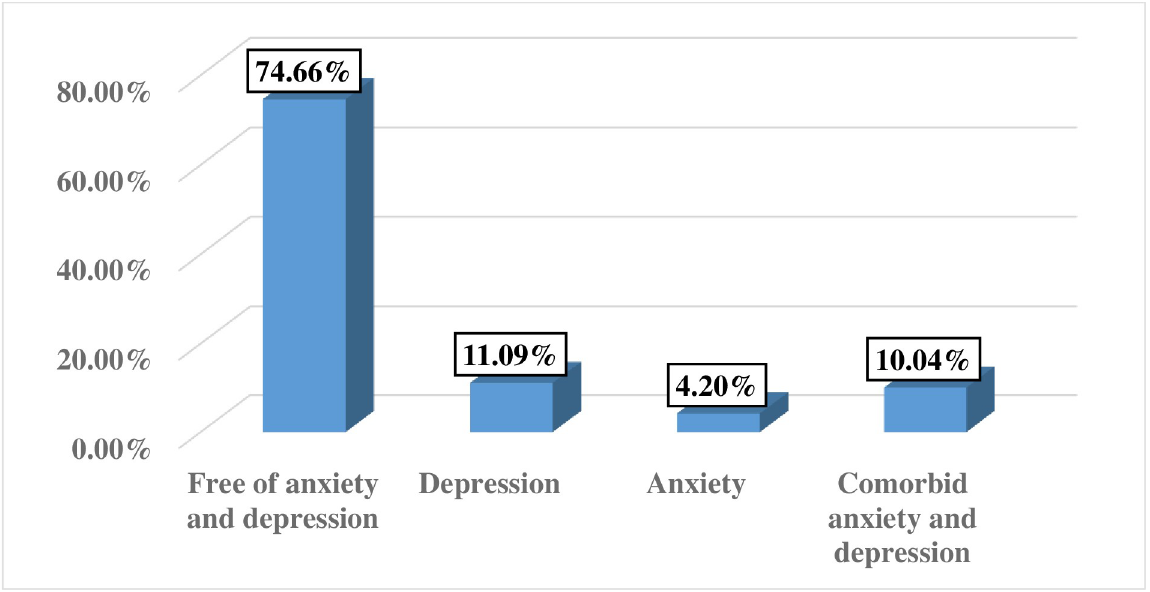
Fig 2. Prevalence of common mental disorders among pregnant women in Arba Minch zuria district, Gamo zone, southern Ethiopia, 2019 (n = 667).